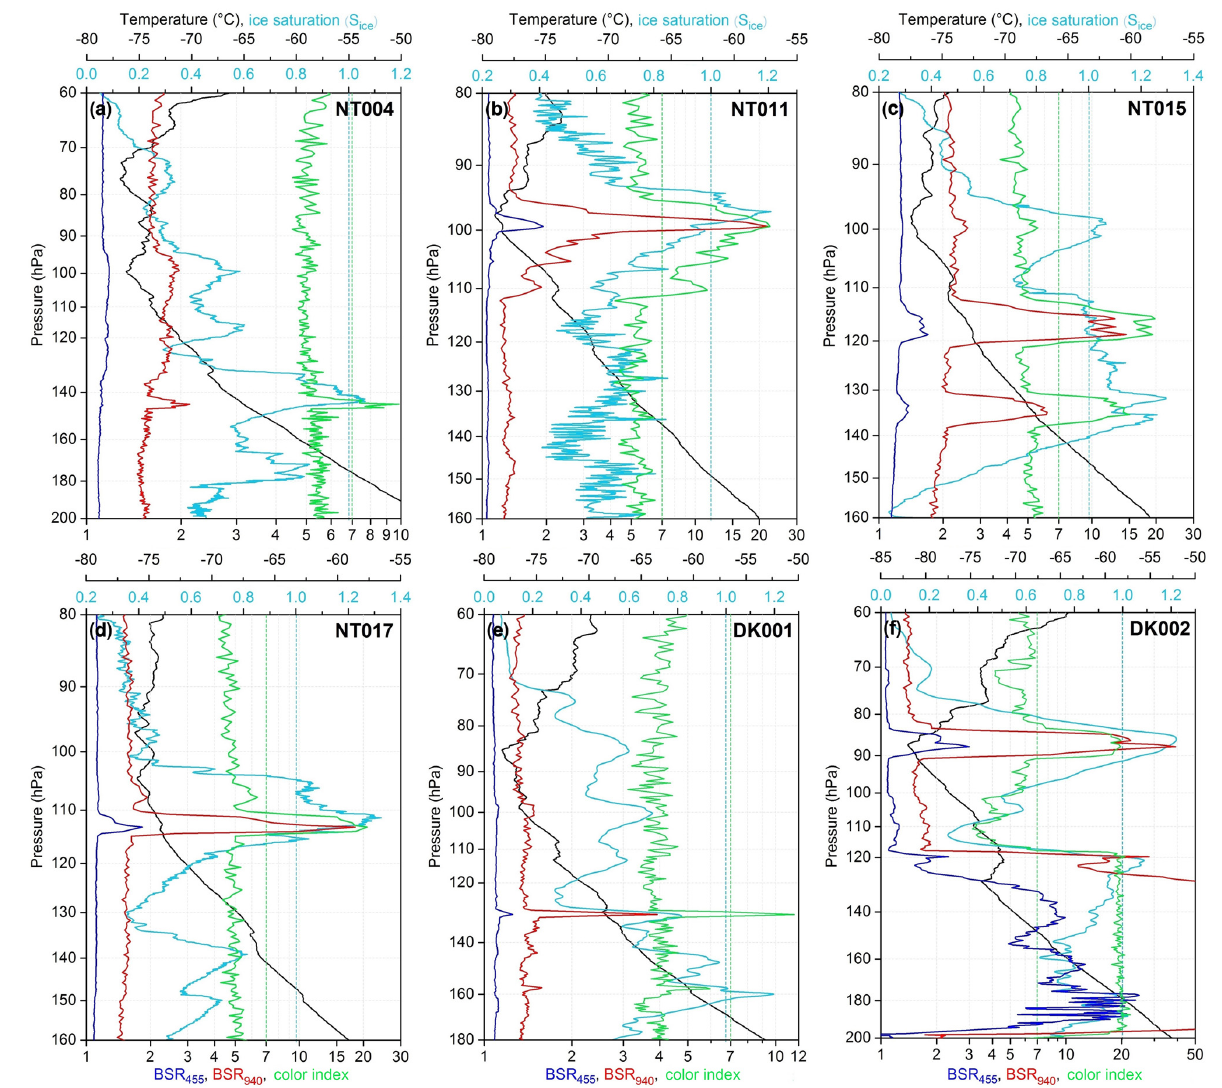
Figure 10. Examples of thin cirrus clouds measured during four individual soundings of the NT16 AUG campaign (a–d) and two soundings of the DK17 campaign (e, f) . Solid lines show temperature (black), ice saturation (light blue), BSR at 455nm (BSR 455 , blue), BSR at 940nm (BSR 940 , red) and the color index (green). Vertical dashed lines mark the S ice = 1 (light blue) and the color index = 7 (green) thresholds, used for cloud-filtering (see Sect. 6.1). Sounding identification numbers are noted in black in the top-right corner of each panel; for the date, time and payload of each sounding, see Table S1 in the